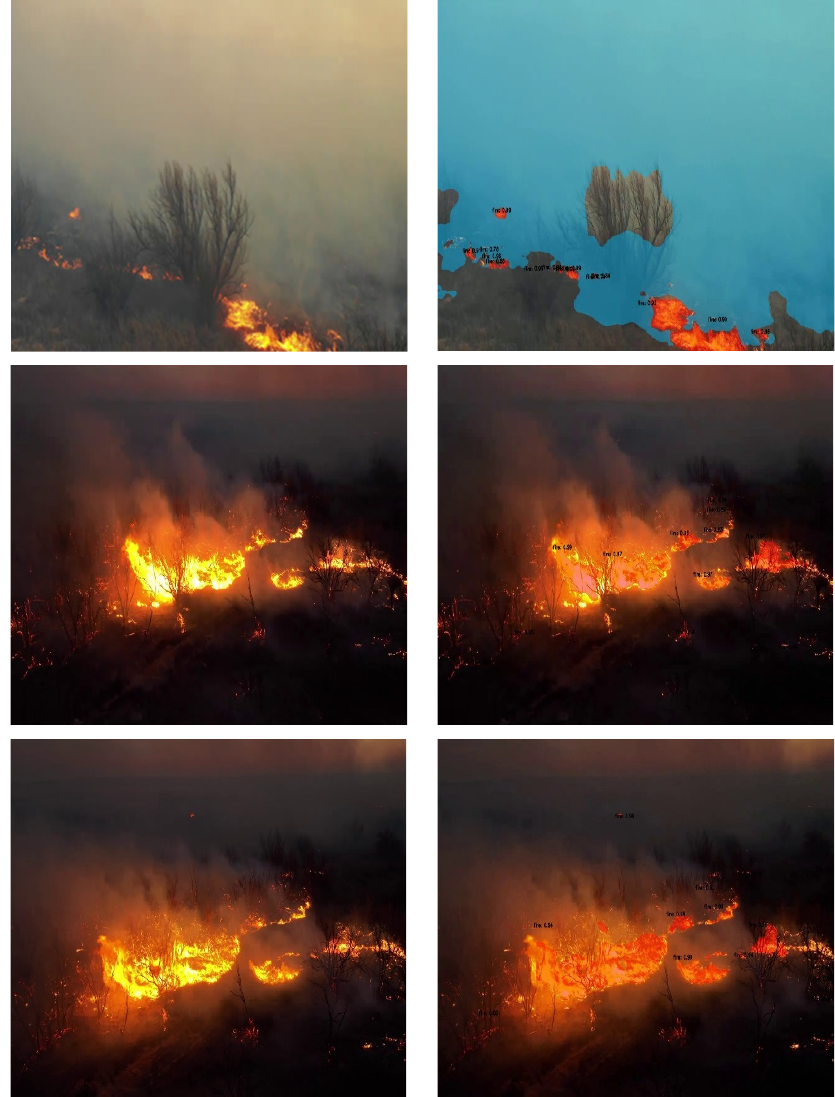
Figure A1. Results from FLAME dataset.